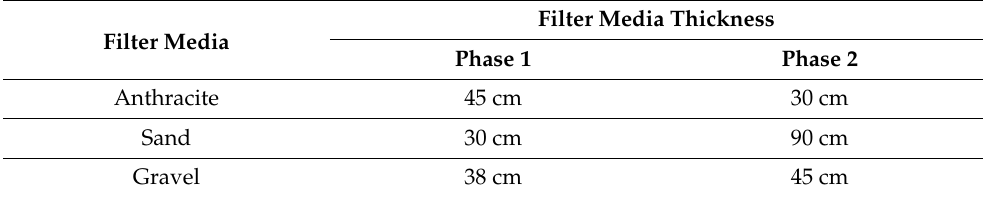
Figure 1. Process flow of Ngamoeyeik WTP. PACl: poly-aluminum chloride. Table 1. Thickness of filter media.